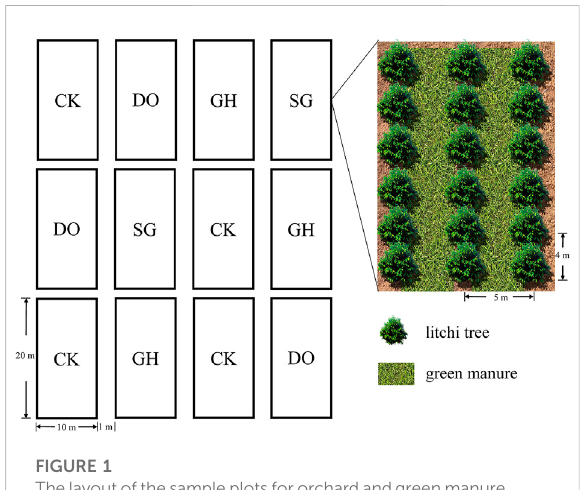
FIGURE 1 Thelayoutofthesampleplotsfororchardandgreenmanure. CK: litchi orchard with no intercropping; DO: litchi orchard intercropped with Desmodium ovalifolium ; GH: litchi orchard intercropped with Grona heterocarpos ; SG: litchi orchard intercropped with Stylosanthes guianensis